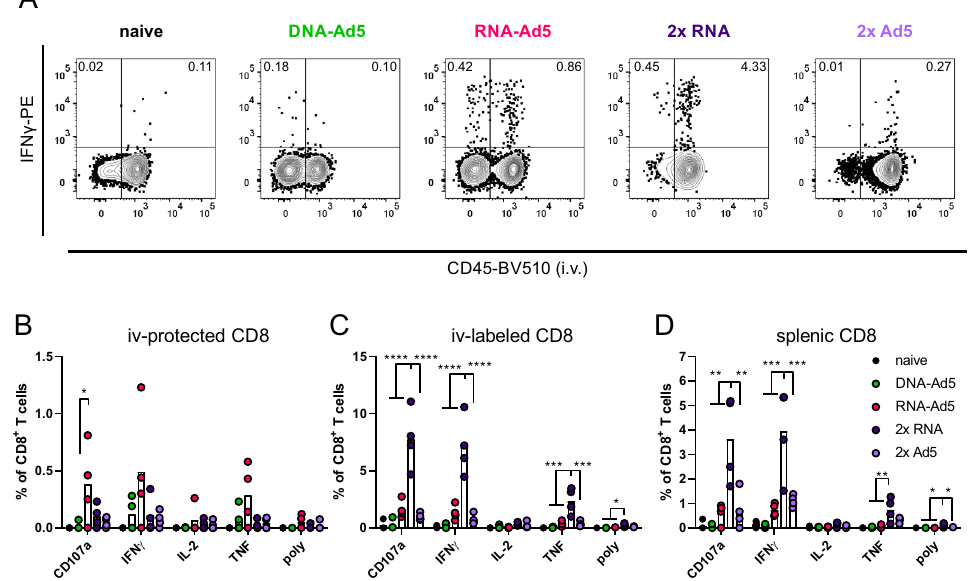
Fig. 8 Spike-speci fi c CD8 + T cell responses. C57BL/6 mice were vaccinated according to Fig. 5A. Lung ( B and C ) and spleen homogenates ( D ) were restimulated with a peptide pool covering major parts of S. The responding CD8 + T cells were identi fi ed by intracellular staining for accumulated cytokines or staining for CD107a as degranulation marker. A Representative contour plots showing IFN γ production in iv + and iv − lung CD8 + T cells. The gating strategy is shown in Supplementary Fig. 3. Bars represent group means overlaid with individual data points; all groups n = 4 (exception: n = 3 for DNA-Ad5 in D ). Data were analysed by one-way ANOVA followed by Tukey ’ s multiple comparison test. Statistically signi fi cant differences are indicated only among the different vaccine groups; p values indicate signi fi cant differences (* p < 0.05; ** p < 0.005; *** p < 0.0005; **** p < 0.0001). poly; polyfunctional T cell population positive for all assessed markers. Representative data from one out of three independent experiments with slightly different end time points are shown.